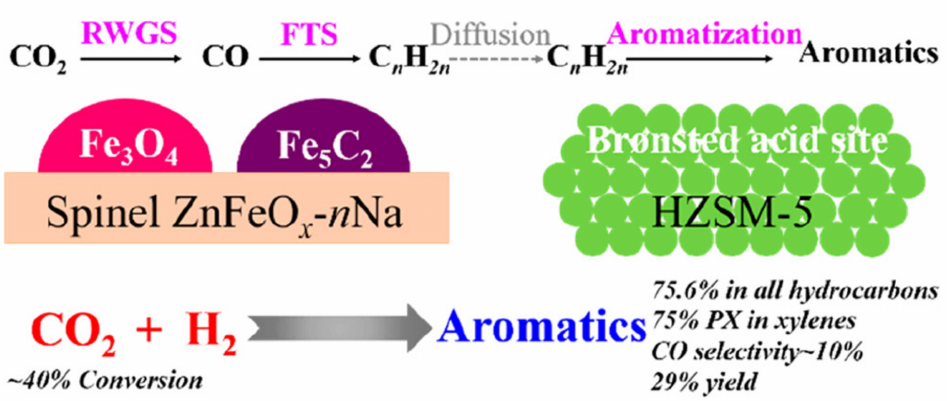
Figure 10. Illustration of the reaction routes of CO 2 hydrogenation to aromatics over the ZnFeO x - nNa/HZSM-5 catalysts. Reprinted with permission from Cui et al. [60]. Copyright (2019) American Chemical Society. Table 4. Representative catalysts and their performance for direct hydrogenation of CO 2 to